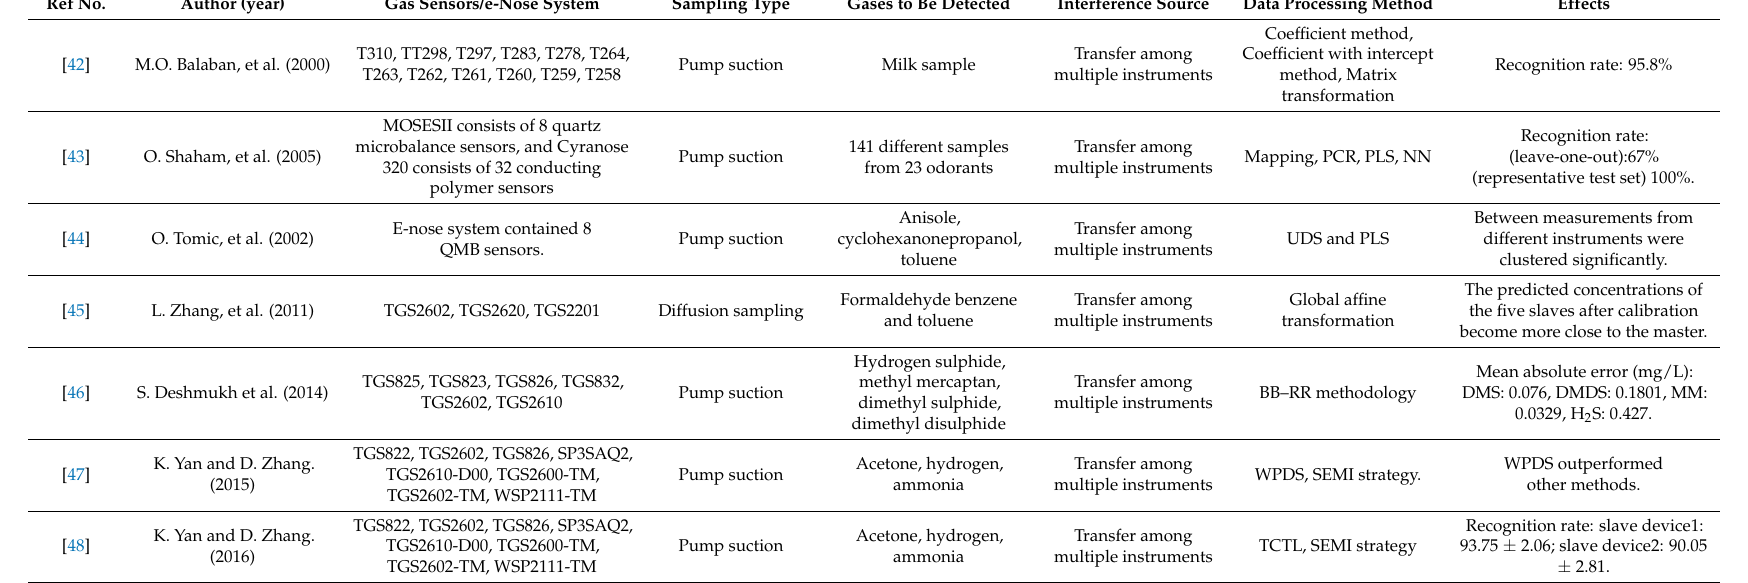
Table 4. Methods for suppressing the interferences from transfer among multiple